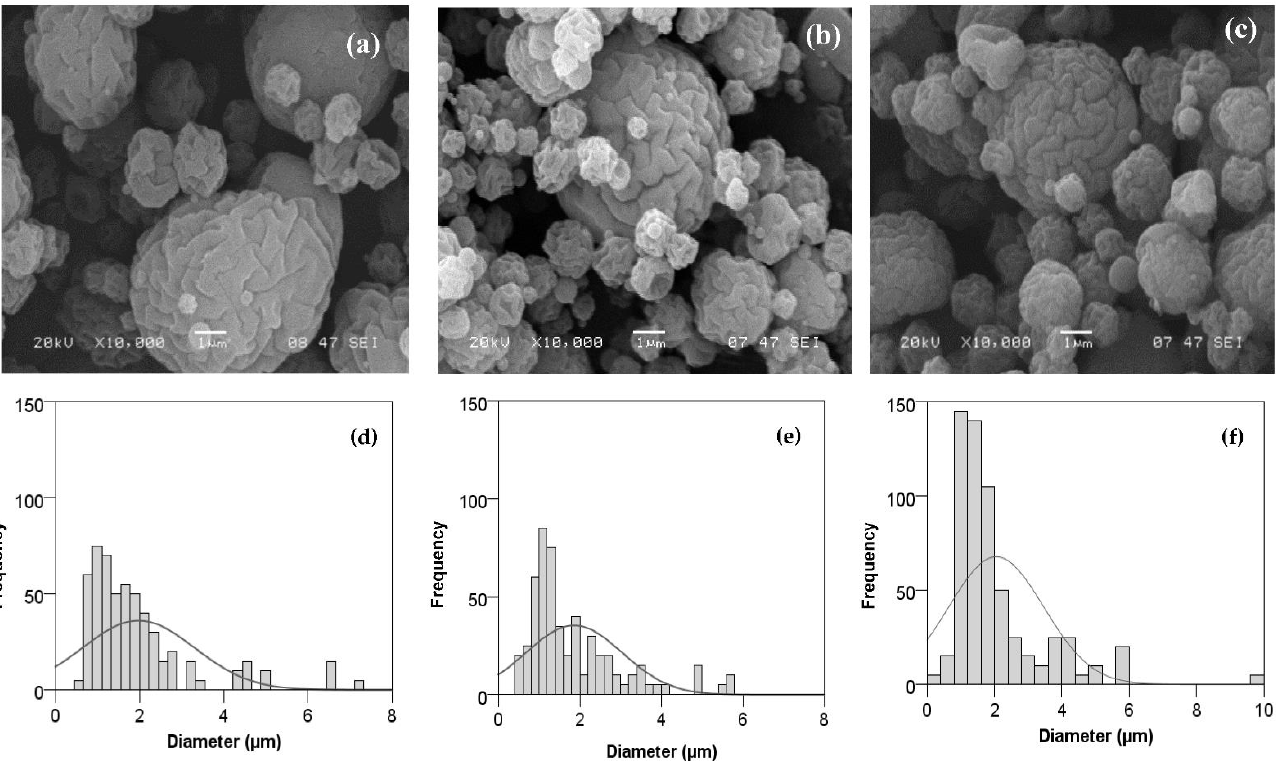
Figure 5. SEM images and size distribution (determined by ImageJ) of Flavourzyme ® loaded in chitosan − TPP microcapsules at 130 °C inlet temperature. Enzyme concentration in % ( v / v ): 0.04 ( a , d ), 0.1 ( b , e ), and 0.16 ( c , f ).